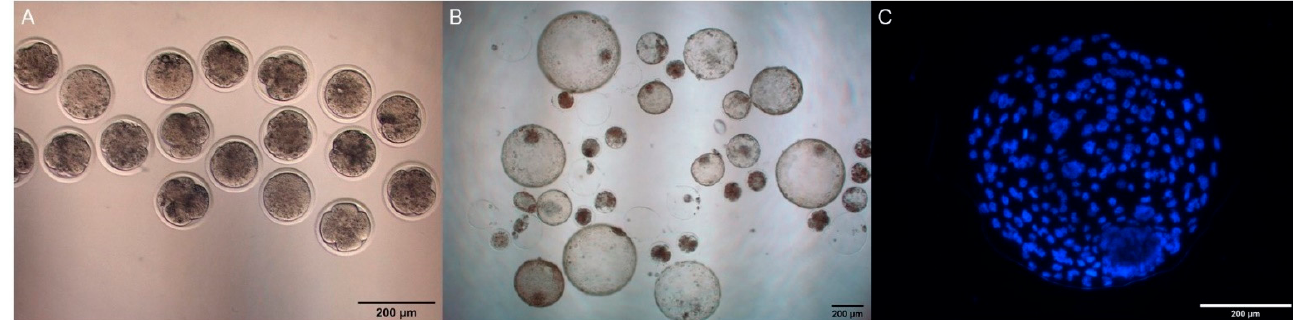
Figure 1. In vitro produced goat embryos. ( A ) Cleavage rate on Day 2 after IVF assessed by stereomicroscope; ( B ) Blastocysts on Day 8 after IVF assessed by stereomicroscope; ( C ) expanded blastocyst stained with Hoechst 33258 assessed by epifluorescence inverted microscope. The scale bar is set at 200 µm.